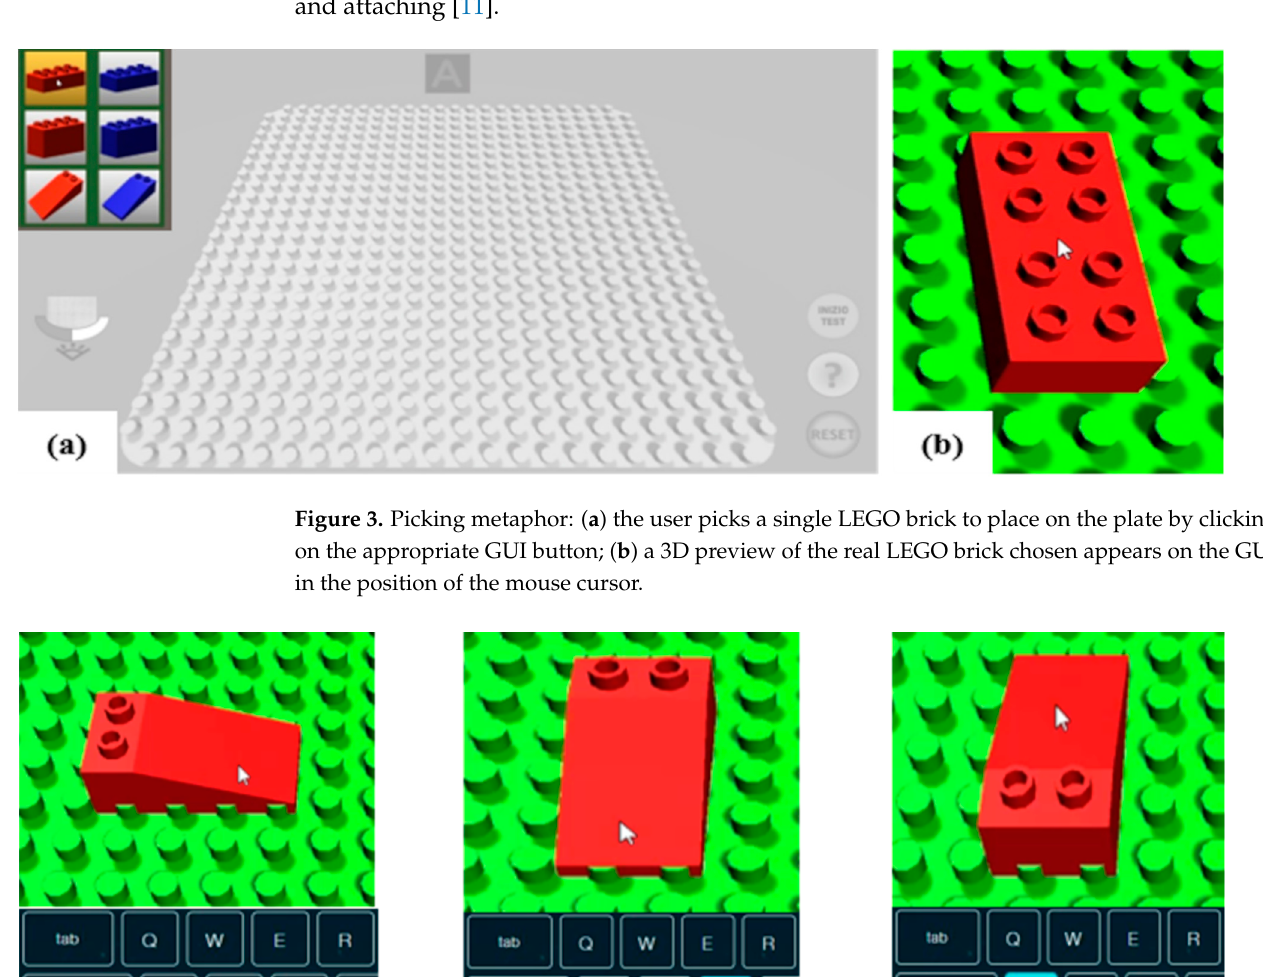
Figure 4. Rotating metaphor: ( a ) initial orientation and that obtained with ( b ) a clockwise rotation, ( c ) or a counterclockwise rotation of the picked LEGO brick. ( c ) or a counterclockwise rotation of the picked LEGO